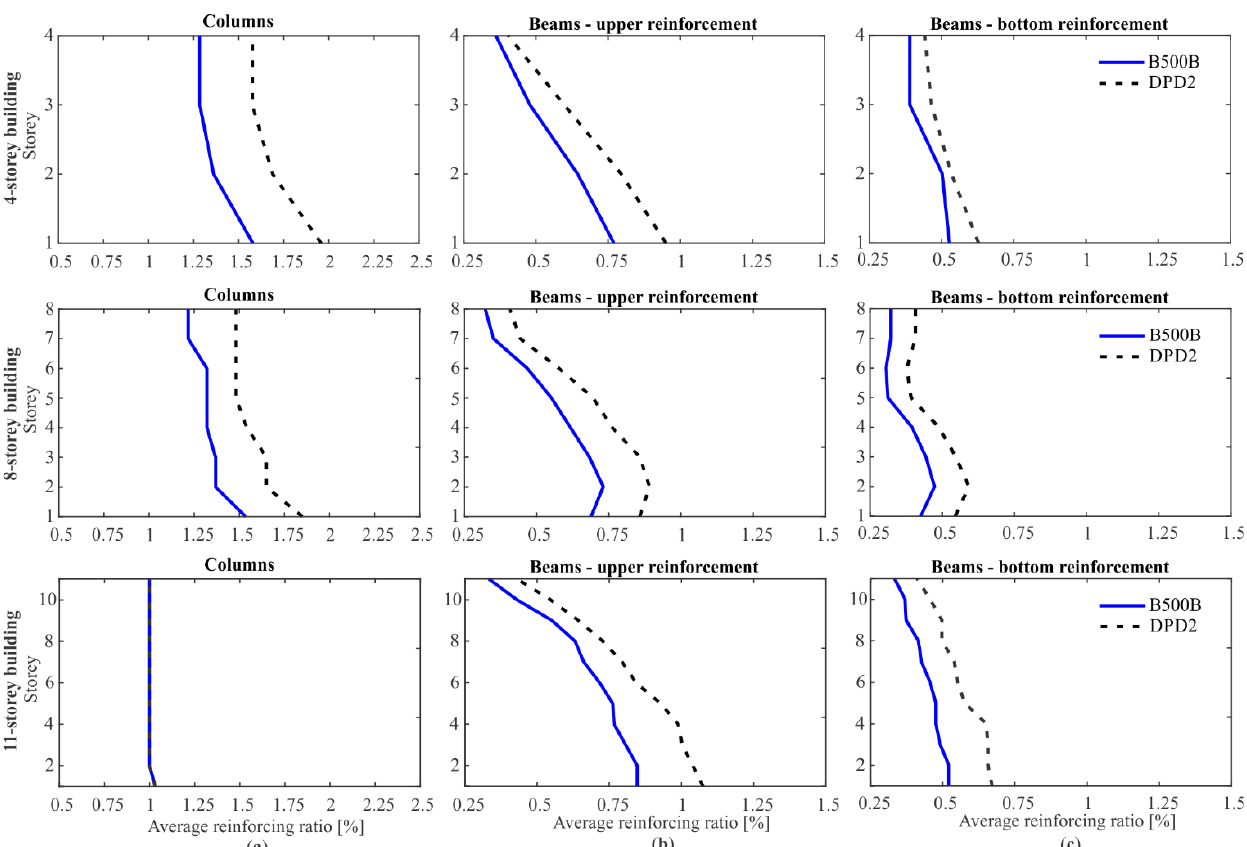
Figure 9. Average longitudinal reinforcing ratios in critical regions of ( a ) columns and ( b ) and ( c ) beams at storey level of 4-, 8- and 11-storey building.